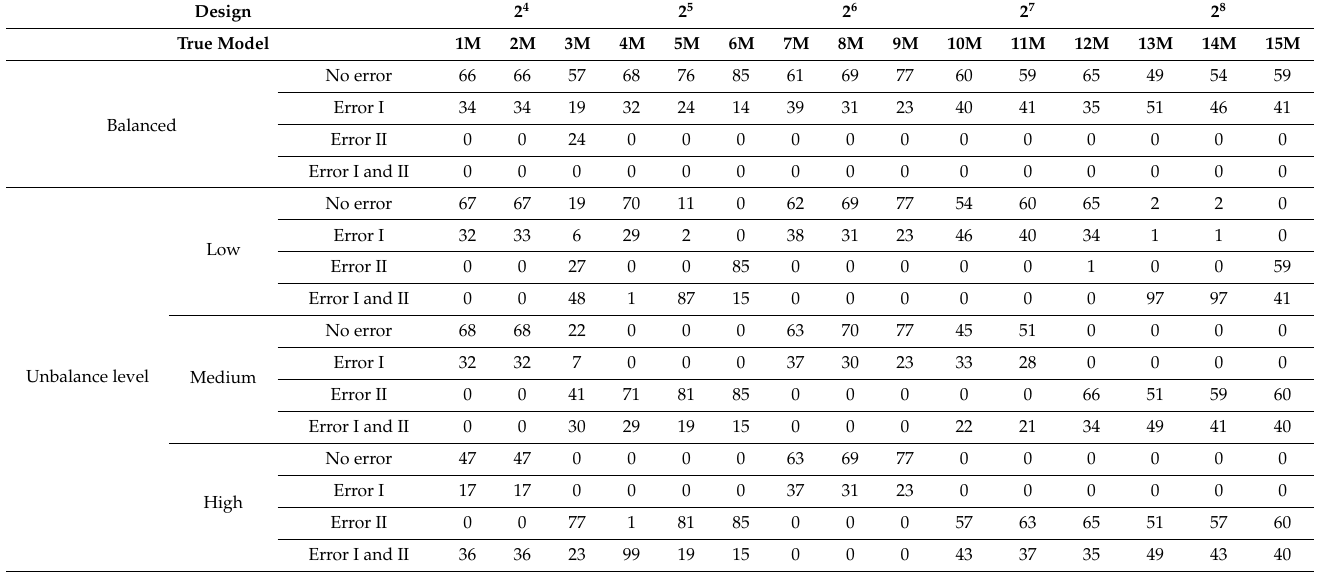
Table 8. % Error behavior with medium